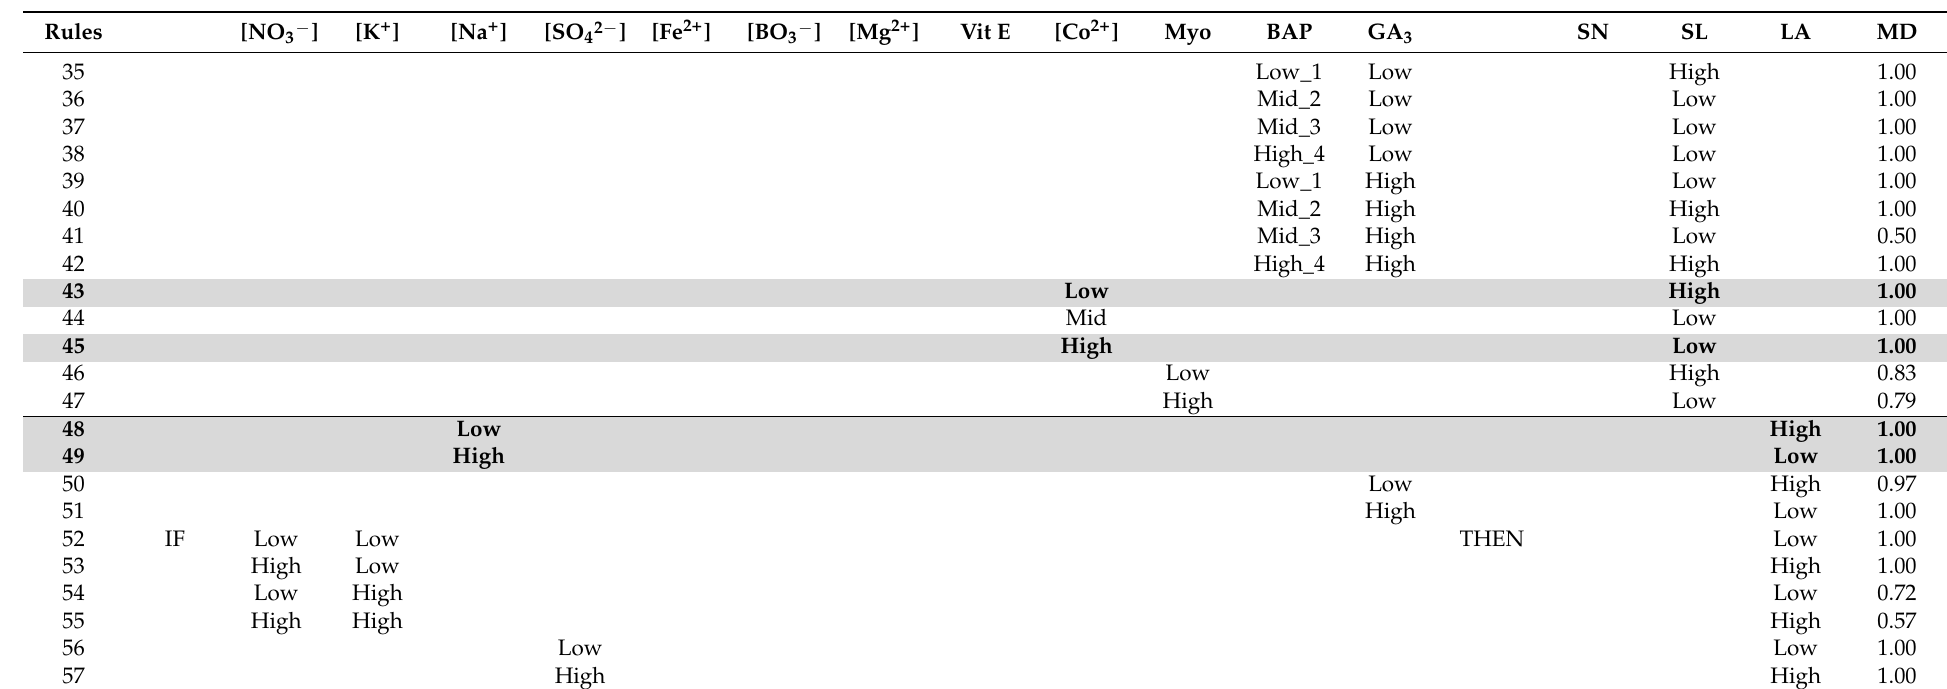
Table 3. Rules for morpho-physiological quality responses (SQ: Shoot quality; BC: basal callus and H: hyperhydricity) with their membership degree (MD)